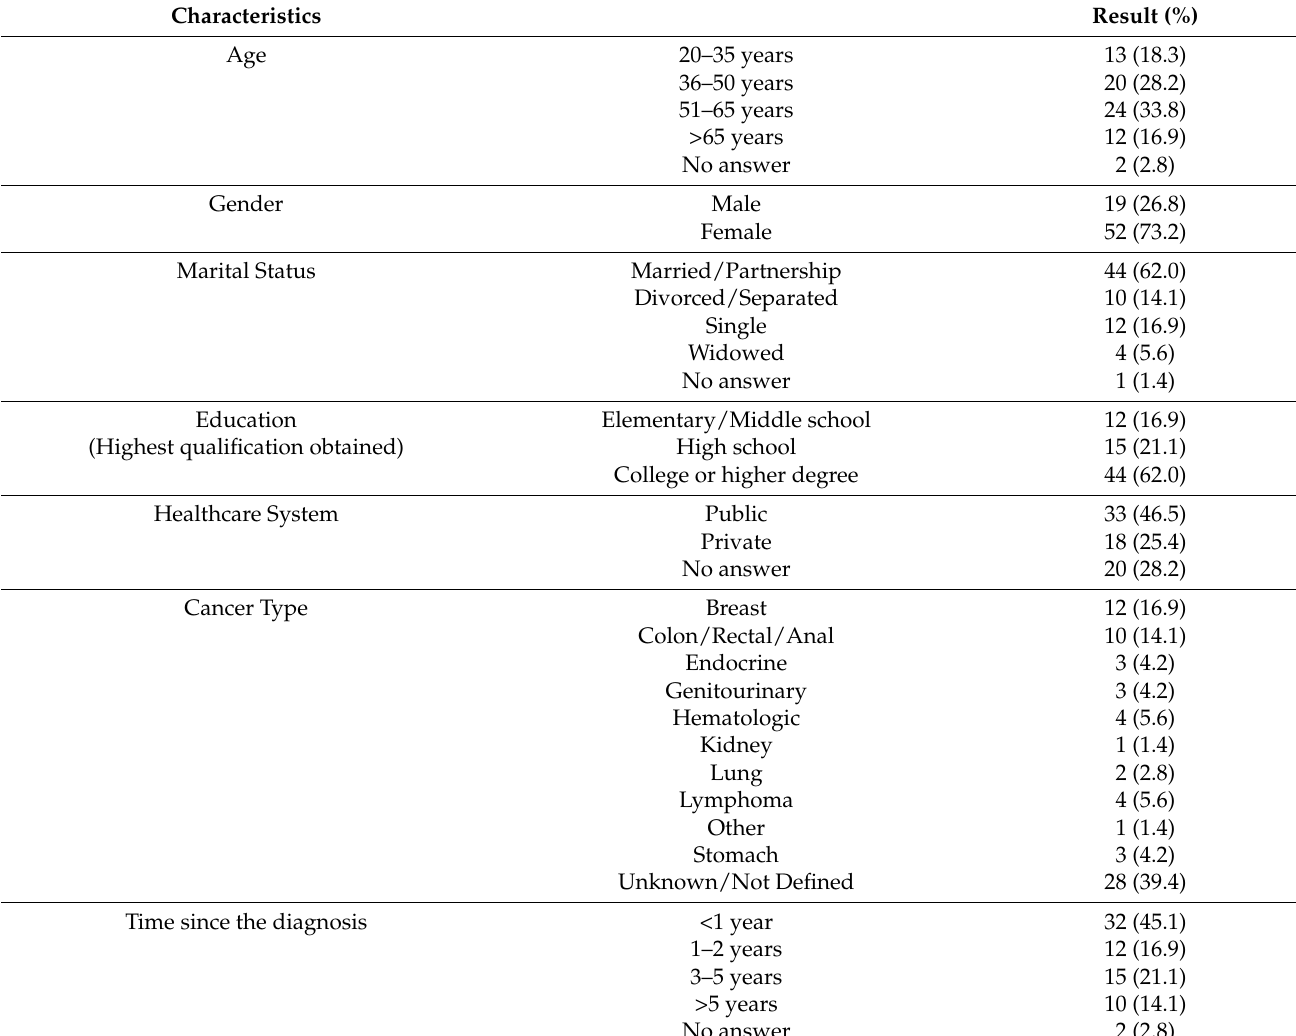
Table 1. Sociodemographic and clinical profile of patients’ sample ( n =